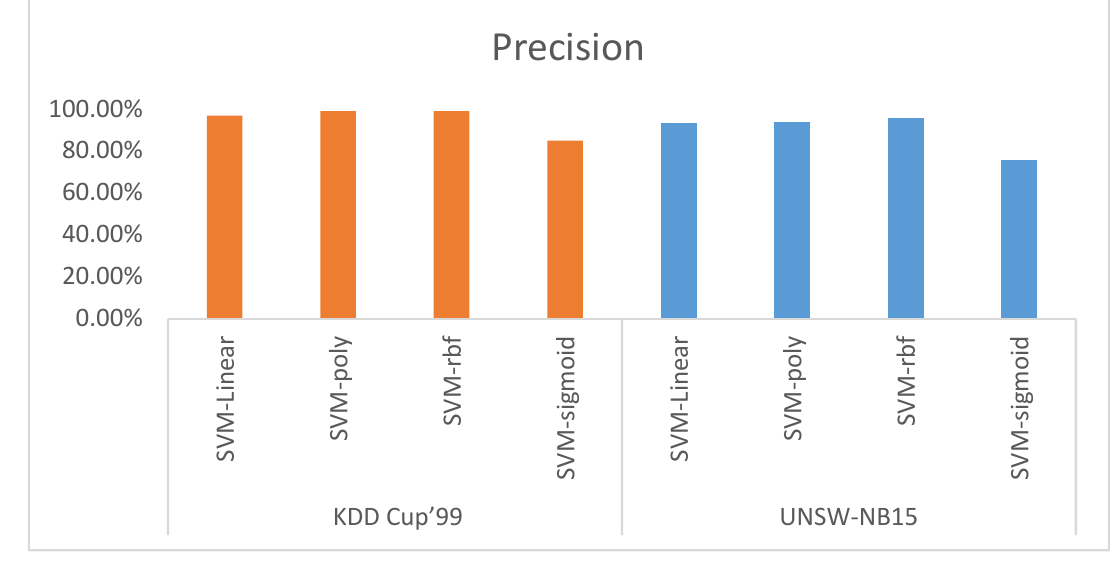
Figure 8. Precision